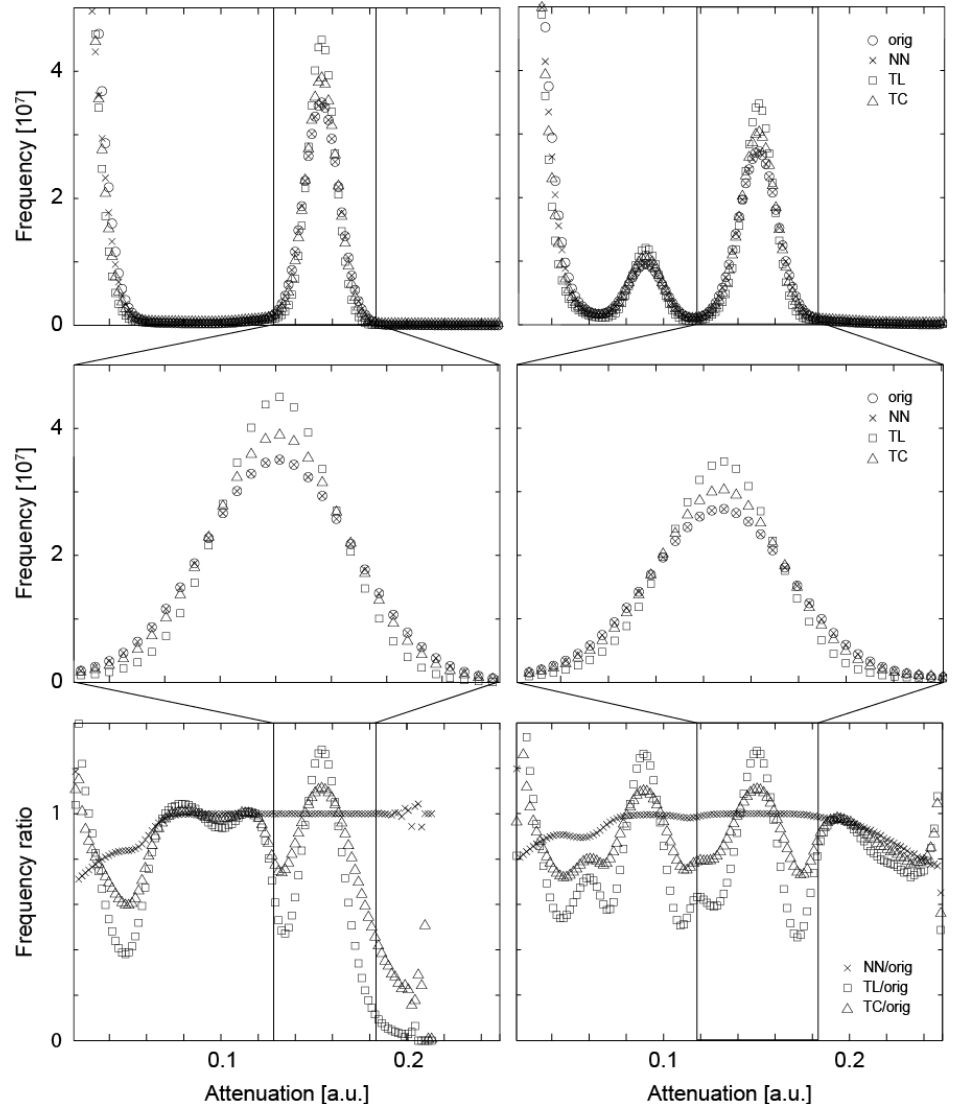
Figure 1. The attenuation histograms of the registered μCT datasets differ from the one of the original data. For the original data and the three interpolation methods, i.e. , nearest neighbor (NN), the tri-linear (TL), and the tri-cubic (TC), the histograms of the entire volumes (top) and histograms related to enamel (middle) are displayed. For the plots in the bottom row, the point-wise ratio between the histograms of the interpolated and original data was represented. For the two crown pieces (left and right column, respectively) the NN interpolation does much less influence the histogram than the TL and TC interpolation procedures. Thus, the NN algorithm is selected for the joint histogram analysis, see